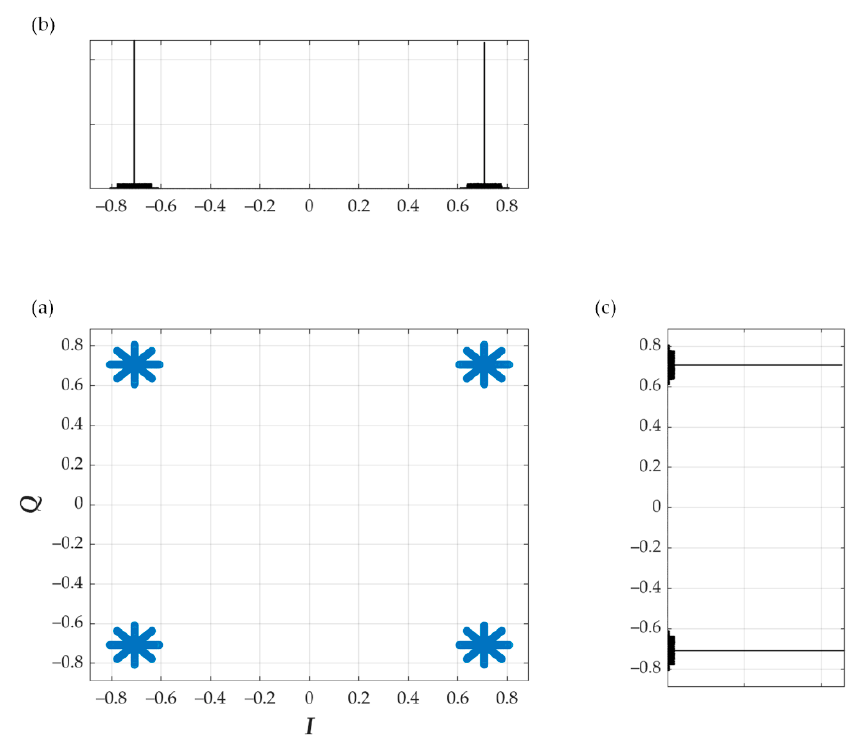
Figure 8 . ( a ) Constellation ( b ) in-phase and ( c ) quadrature histograms for 4 QAM cover and DCM covert channel with M = 4 and for random A m .